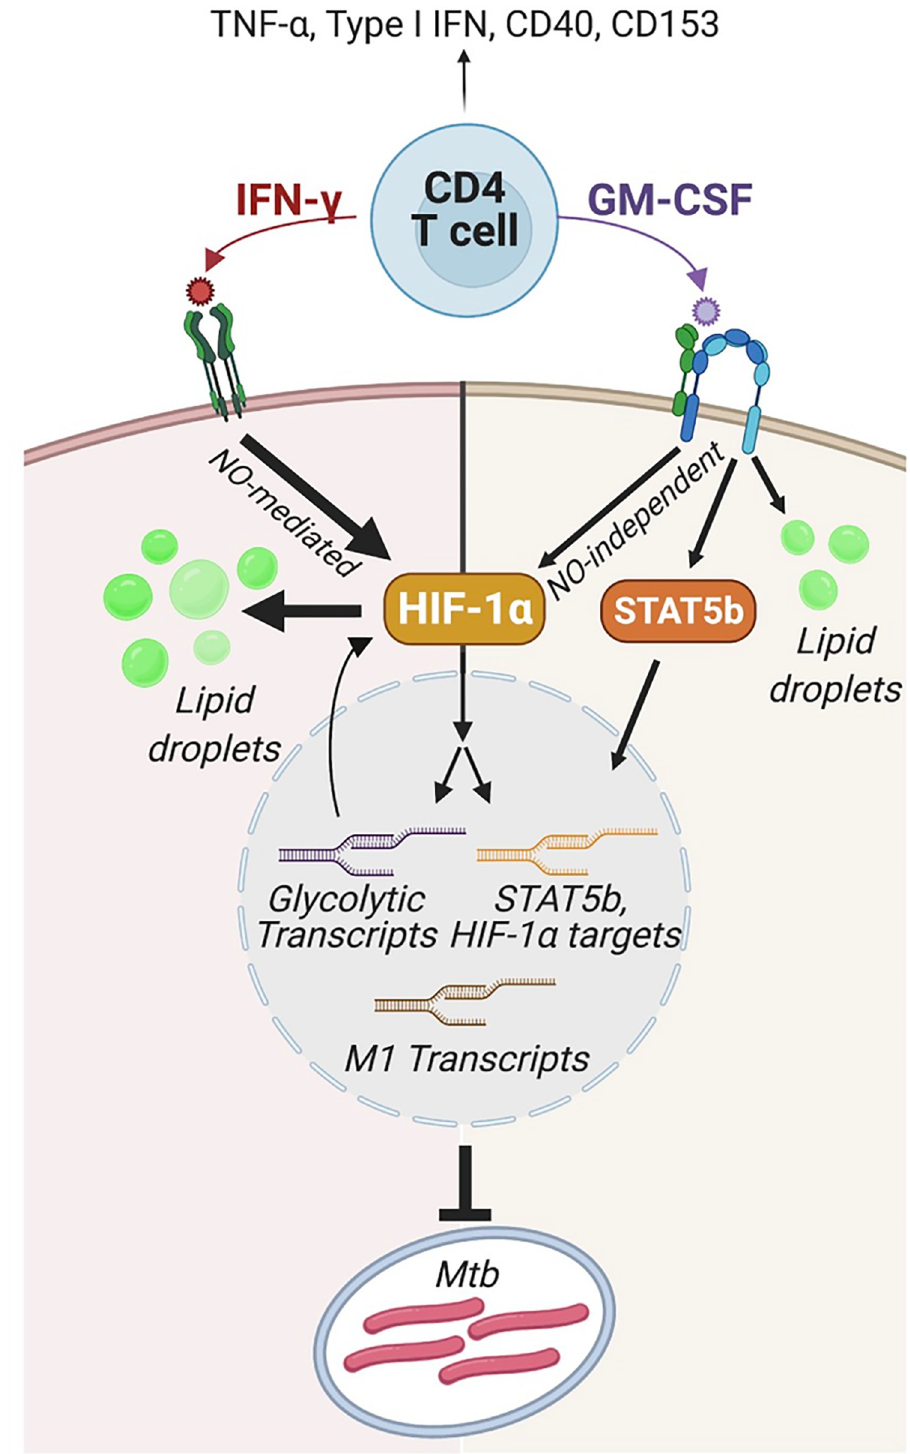
Fig 7. Model for IFN- γ -independent CD4 T cell-mediated control of M . tuberculosis by GM-CSF and HIF-1 α . CD4 T cells secrete immune activating cytokines including TNF- α and Type I IFN and express the cell surface molecules CD40 and CD153, none of which mediate control of M . tuberculosis in macrophages. IFN- γ activates macrophages to control M . tuberculosis in part by stabilizing HIF-1 α expression in a nitric oxide (NO)-dependent manner to drive a metabolic switch to glycolysis and the production of macrophage lipid droplets, and HIF-1 α is